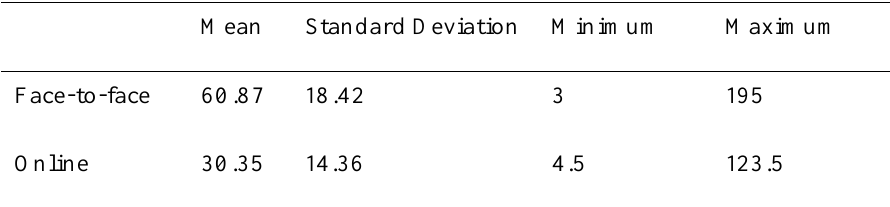
Description of the Variable for Ordinary Credits Taken on the Course Mean Standard Deviation Minimum Maximum Face-to-face 60.87